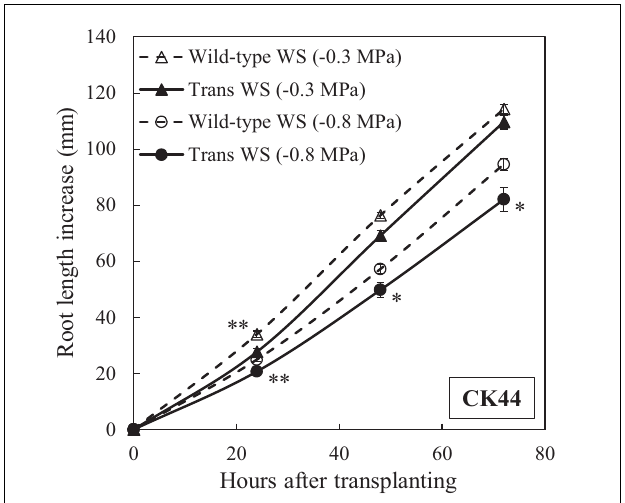
FIGURE 4 | Primary root elongation of CK44 oxalate oxidase transgenic and wild-type lines after transplanting to mild (–0.3 MPa) or moderate (–0.8 MPa) water stress conditions. Data are means ± SE ( n = 14–20). Asterisks denote significant differences between the transgenic and wild-type lines ( t -test; ∗ P < 0.05; ∗∗ P <